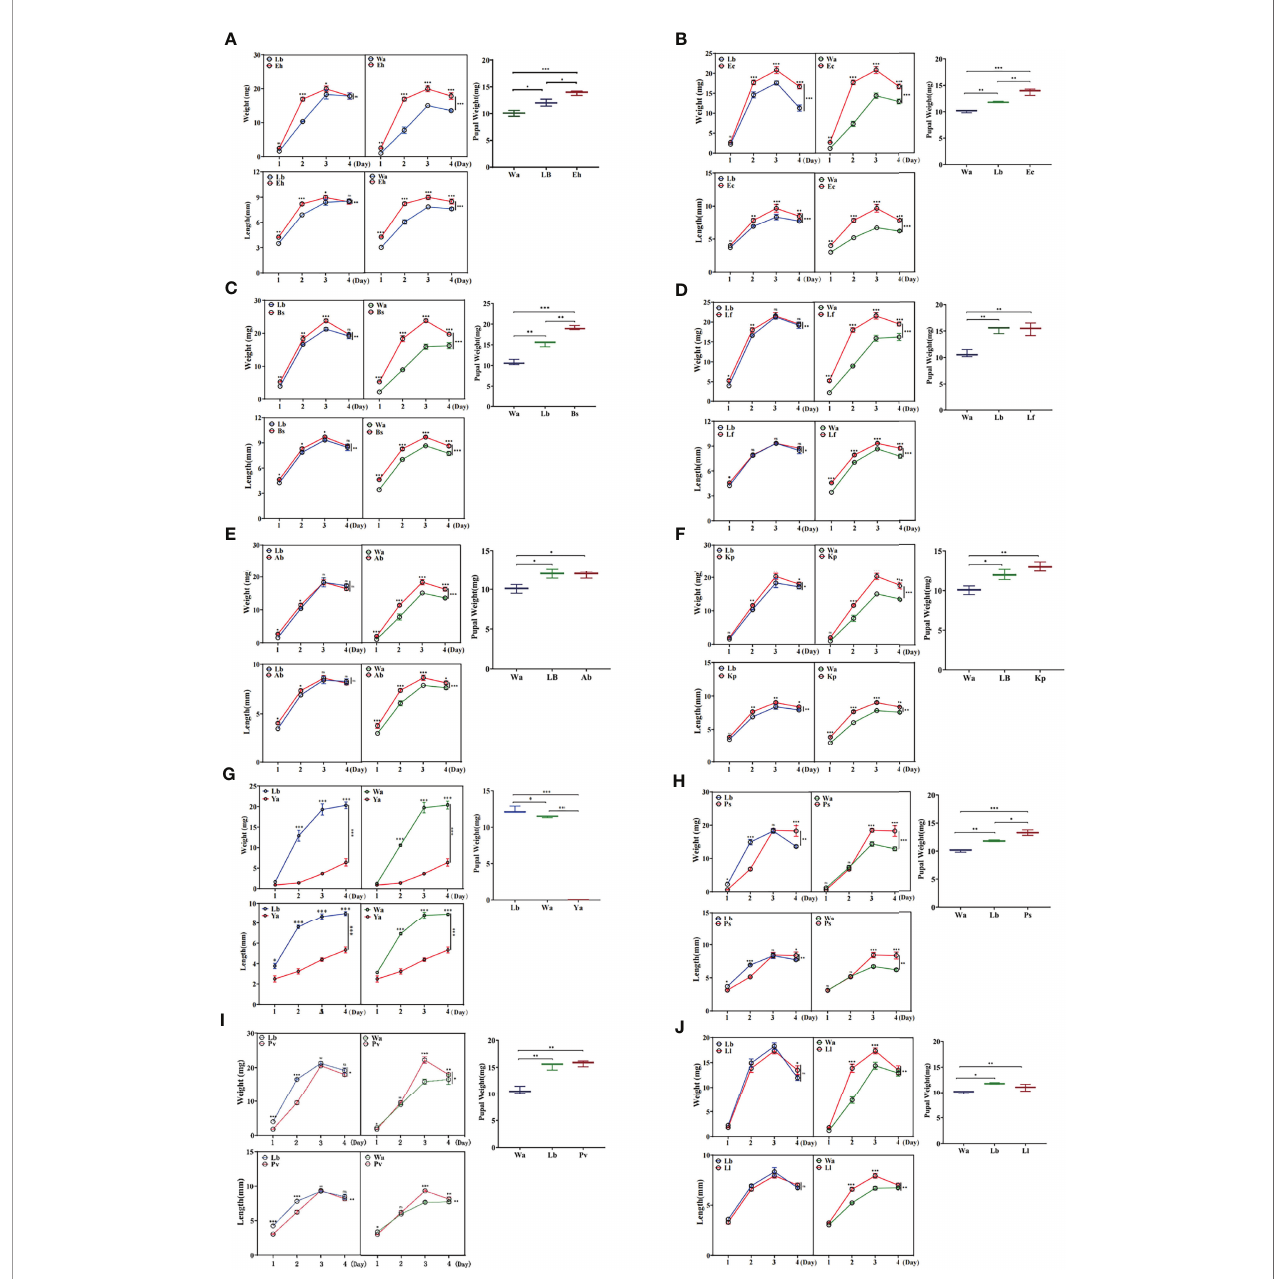
FIGURE 1 | Effects of feeding isolated bacteria on larval development. Eh, Enterobacter hormaechei; Ec, Enterobacter cloacae; Bs, Bacillus safensis; Lf, Lysinibacillus fusiformis; Ab, Acinetobacter bereziniae; Kp, Klebsiella pneumoniae; Ya, Pseudomonas aeruginosa; Ps, Providencia stuartii; Pv, Providencia vermicola; Ll, Lactococcus lactis; Wa, sterile water, blank control group; Lb, Luria-Bertani liquid medium, negative control group; Day 1, Day 2, Day 3, Day 4: the developmental period of house fl y larvae. Pupal weight was measured on the fi rst day they pupated. *p < 0.05, **p < 0.01, ***p <